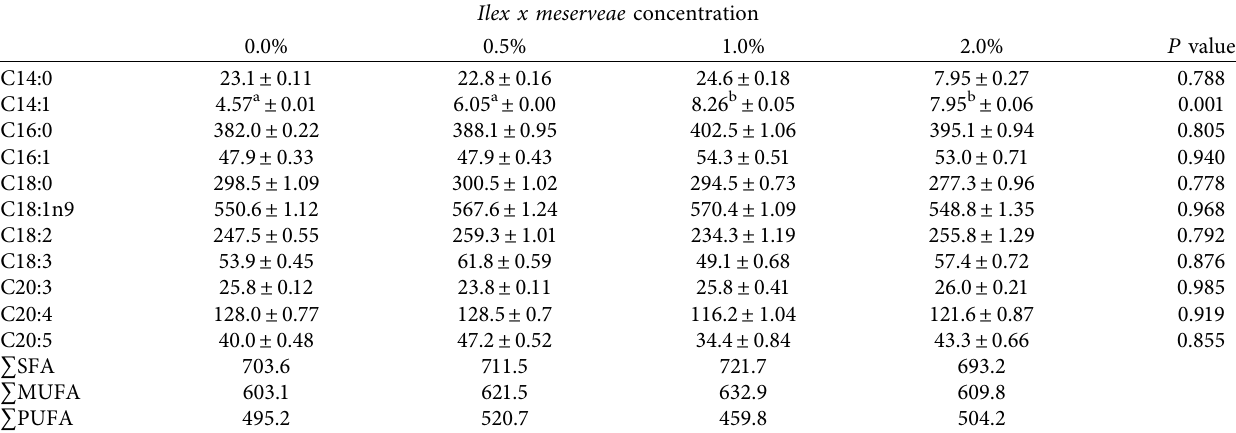
Table 3: Effect of Ilex meserveae on fatty acid profile (mg/100 g muscle) of dry-aged